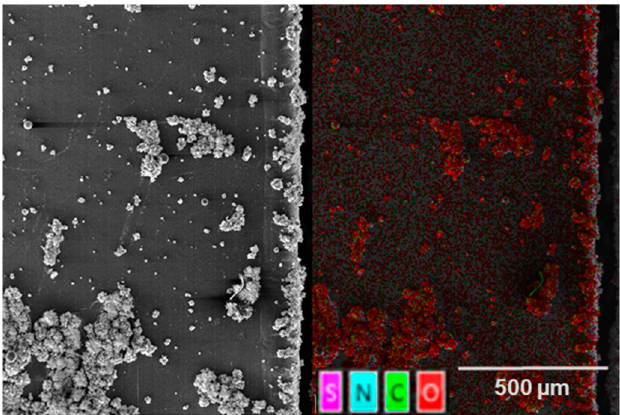
Figure 17. SEM (left) and EDX (right) section of a laser cut lithium sheet: 72.8 W, 490 kHz, 240 ns, dew point − 30 °C, 150 mm/s; PO 99.66%; after 5 months of aging in an atmosphere with a dew point of − 60 °C.